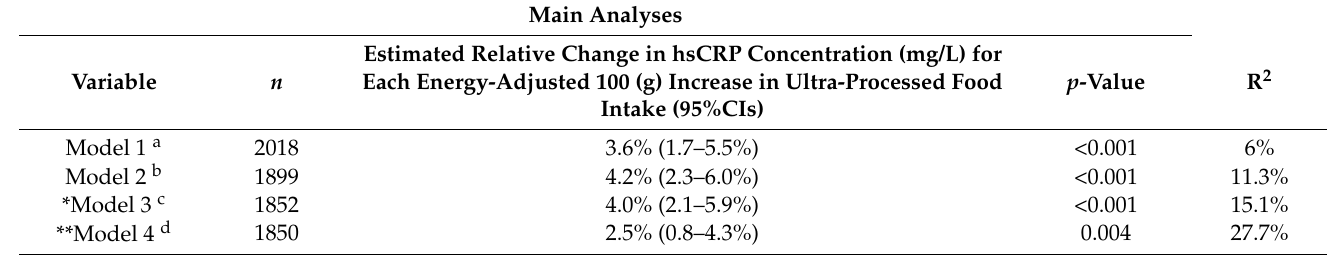
Table 2. Cross-sectional associations between ultra-processed food intake and hsCRP